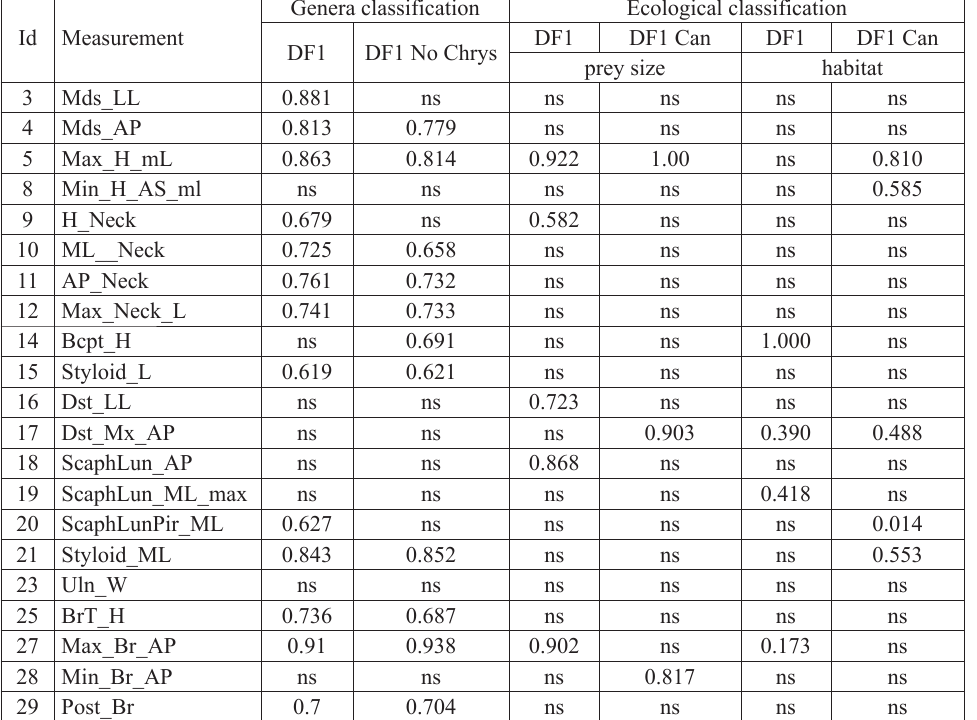
Table 5. Correlation coefficients of the relationship between selected variables and extracted discriminant functions for the proximal and distal measurements. Analyses are based based on the overall sample (N = 92), on a subsample inclusive of all species except Chrysocyon (No Chrys, N = 88), or on a subsample of large Canini only (Can = Canis spp. + Lycaon , N = 36). DF, Discriminant Function; ns, non-significant. For expla- nation of measurement abbreviations see Table